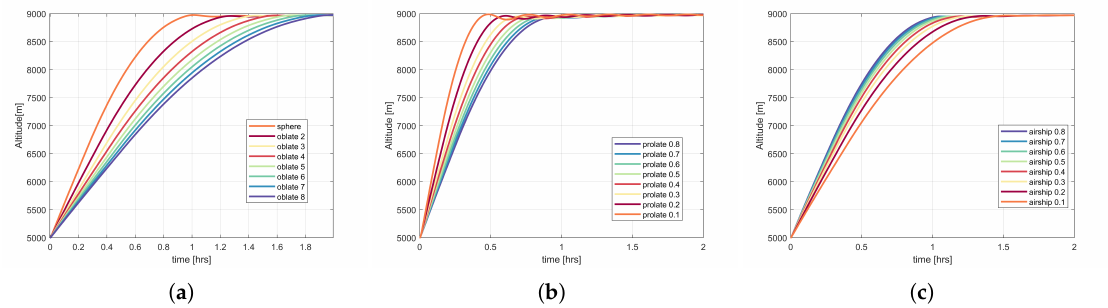
Figure 16. Altitude variation of the OZP balloons for different shapes with varying fineness ratios in order to find the stable fineness ratio on Titan ( a ) oblate ( f : 2–8) ( b ) prolate (0.1–0.8) ( c ) airship (0.1–0.8).